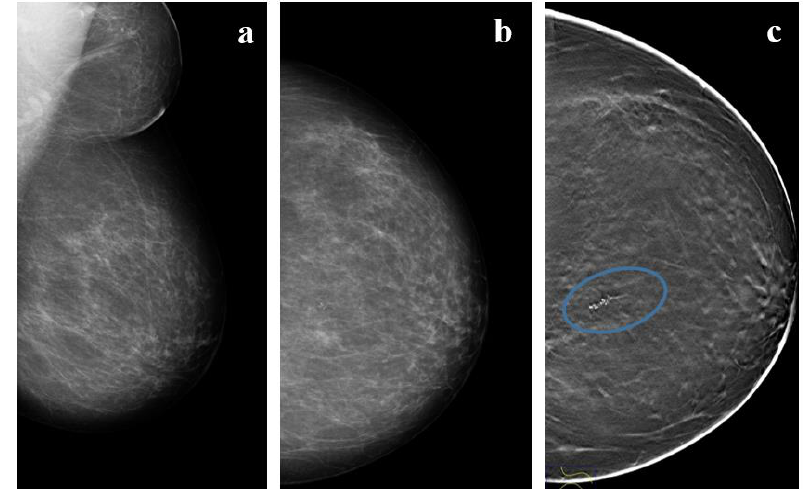
Figure 2. A 57 year-old woman with high-grade DCIS. ( a , b ) Mammograms and ( c ) Tomosyinthesis imaging of the left, almost entirely fatty, breast shows a cluster of fine-linear branching calcifications (circle) in the upper inner quadrant (UIQ) classified using breast imaging-reporting and data system (BI-RADS) as Category IVc.